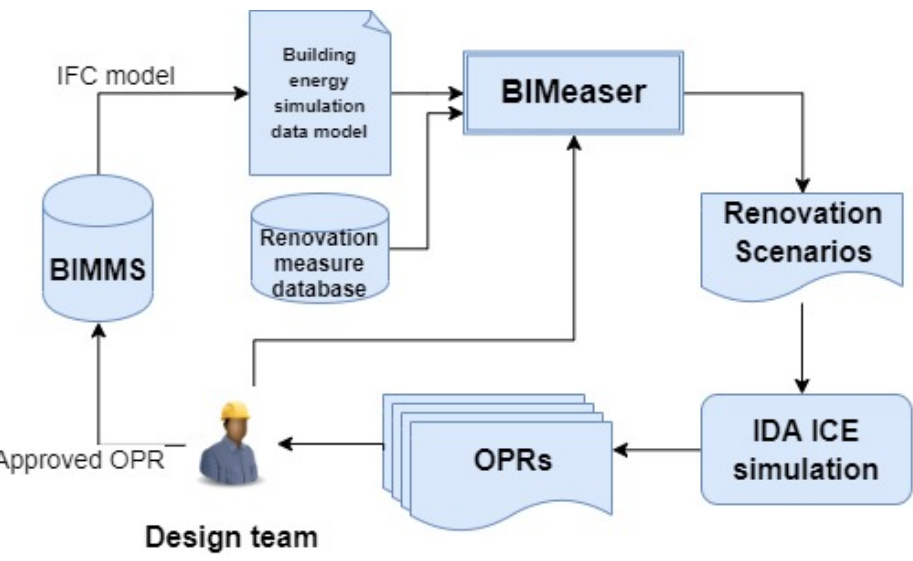
Figure 5. Workflow of the BIMeaser tool .